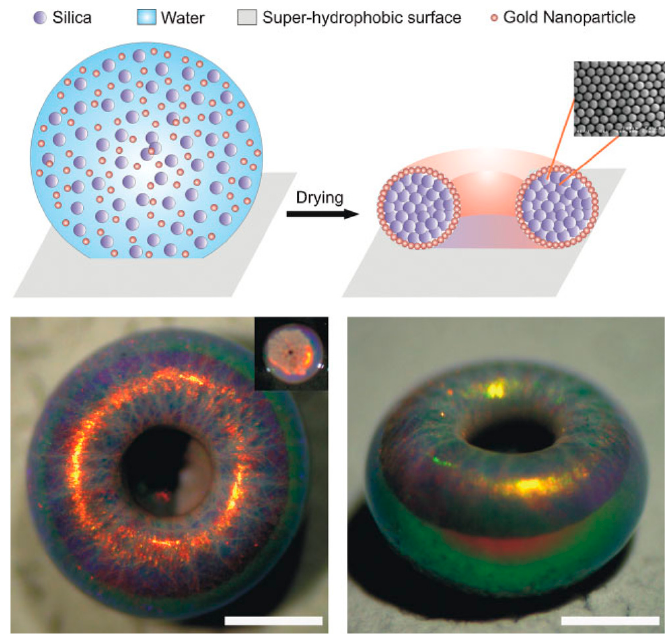
Figure 8. Top: Illustration of the evaporation-induced formation of “doughnut” supraparticles; the inset is showing an SEM of the particle lattice built by 330-nm diameter silica particles. Bottom: Optical micrographs of the final supraparticle from top- (left) and side-view; scale bars are 500 µm. Adapted with permission from [92] (p. 192). Copyright 2010 Wiley.